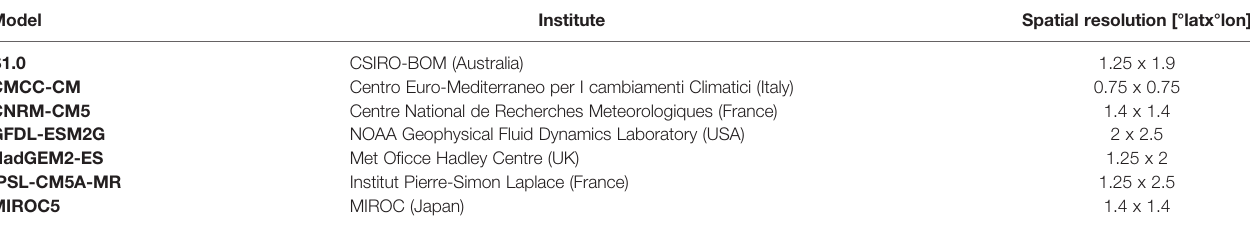
TABLE 3 | CMIP5 models used in this study: name, institution, country and spatial resolution.